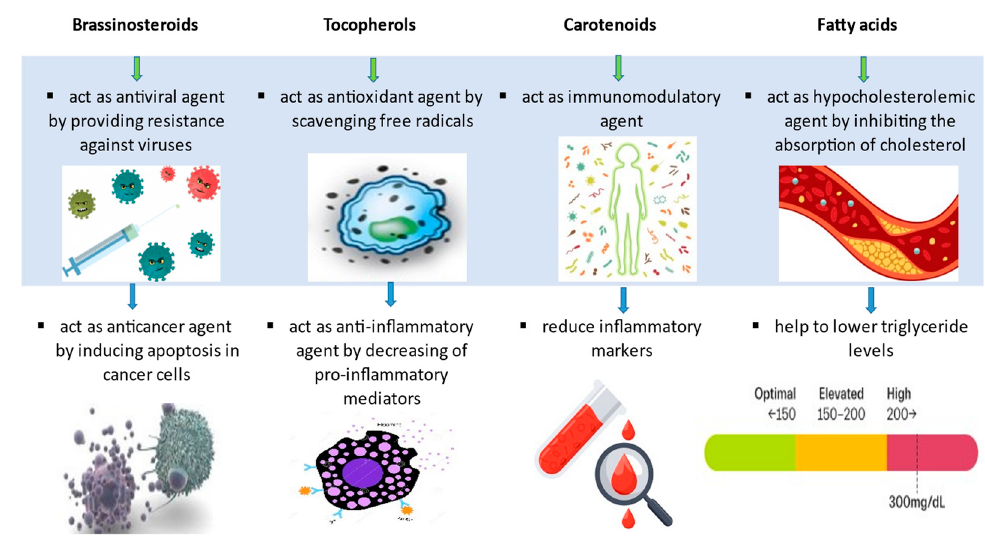
Figure 1. Pharmacological activity of rapeseed biocompounds [43–46].